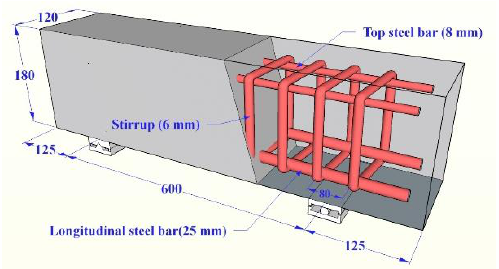
Figure 2. Dimensions and steel reinforcement details of specimens C-2 and H-2 (units: mm). Table 5. Specimen parameters. Table 5. Specimen parameters. Table 5. Specimen parameters. Table 5. Specimen parameters. Table 5. Specimen parameters. Table 5. Specimen parameters. Table 5. Specimen parameters. Table 5. Specimen parameters. Table 5. Specimen parameters. Table 5. Specimen parameters. Table 5. Specimen parameters. Table 5. Specimen parameters. Table 5. Specimen parameters. Table 5. Specimen parameters. Table 5. Specimen parameters. Table 5. Specimen